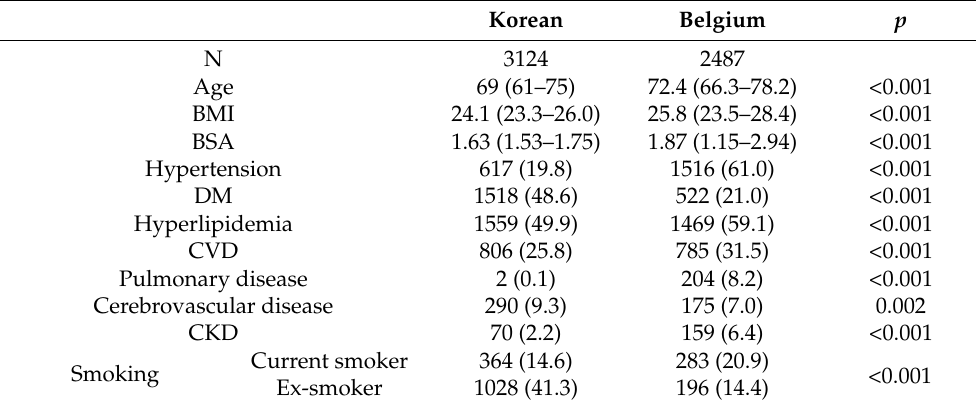
Table 1. Demographic data of the Korean and Belgian cohorts.